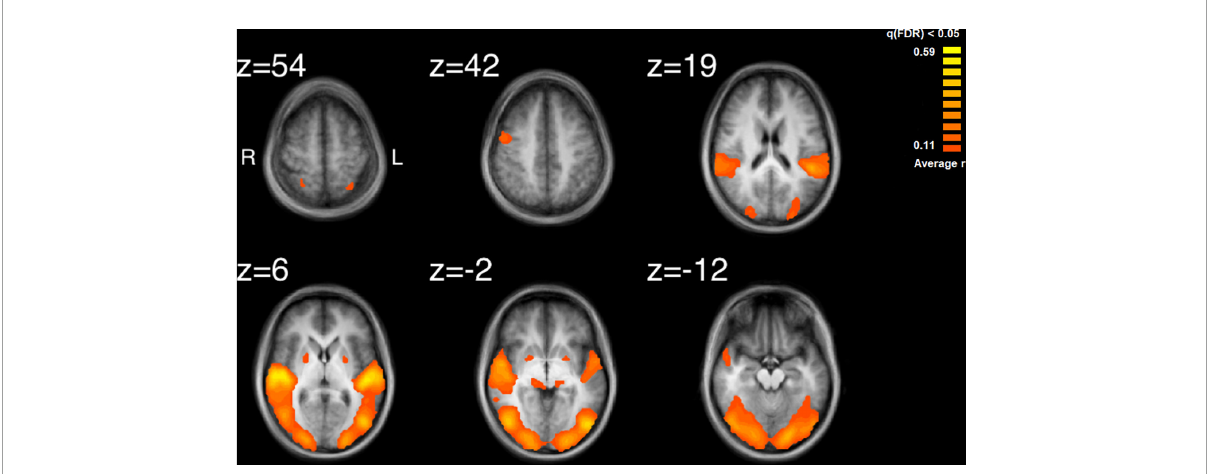
FIGURE2 Results of the inter-subject correlation obtained from the average of all possible pairwise correlation, r, values. Significant regions of ISC include the bilateral superior temporal gyrus, peaking in the right STG, bilateral, occipital areas, the right precentral gyrus and regions in the midbrain. Images are shown in radiological format: left brain to image right and right brain to the image left.